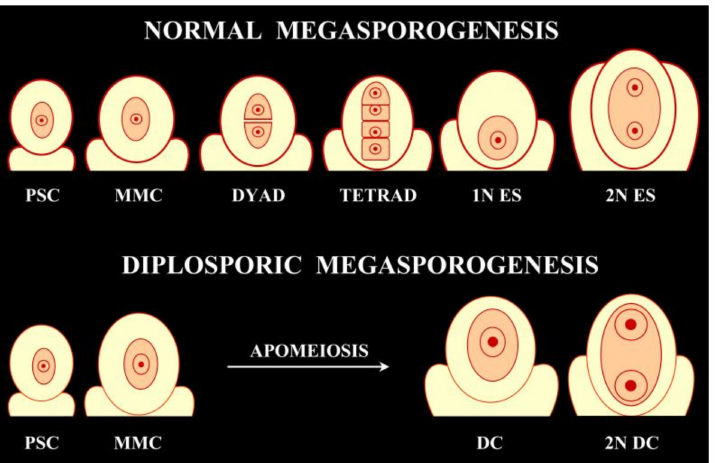
Figure A2. Developmental pathway of the primary sporogenic cell (PSC) and megaspore mother cell (MMC) during normal megasporogenesis (wild-type plants) and apomeiosis in the diplosporic TNE mutant. The diplosporic cells (DC) and binucleate embryo sacs (2N DC) were cytologically recognizable from sexual counterparts (1N ES and 2N ES) on the basis of both nucleolus diameter and integument length (for further details on the features of the apomeiotic mutant, see [19]). At the same time, some DTA plants were treated with three different auxin solutions, starting from the pre-meiotic stage. In particular, inflorescences of these plants were sprayed with 10 mg/L NAA (naphthalene acetic acid), 8 mg/L 2,4-D (2,4-dichlorophenoxyacetic acid), and 6 mg/L 2,4,5-T (2,4,5-trichlorophenoxyacetic acid). Treatments were repeated every two days until